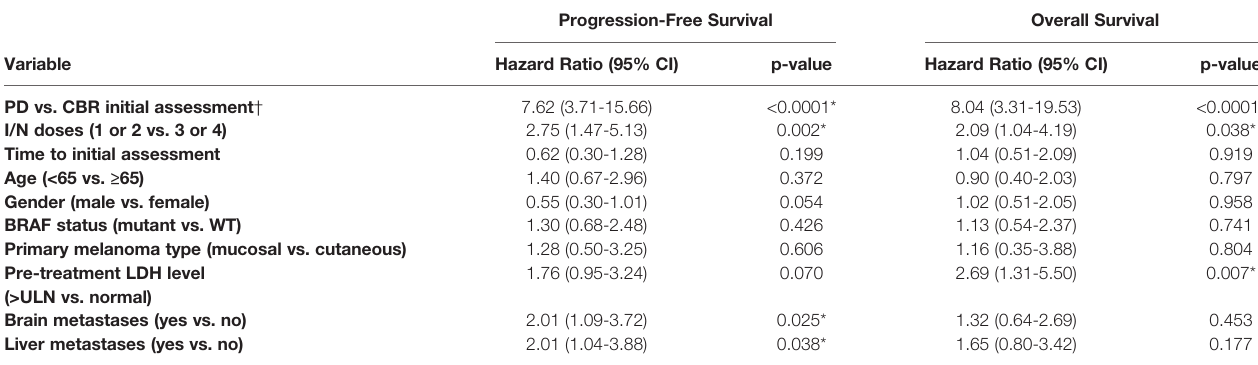
TABLE 3 | Multivariable Cox regression of progression-free survival and overall survival on the number of I/N (ipilimumab/nivolumab) doses and prognostic variables among patients who had response assessment after 1 or 2 doses of I/N. n = 118. Progression-Free Survival